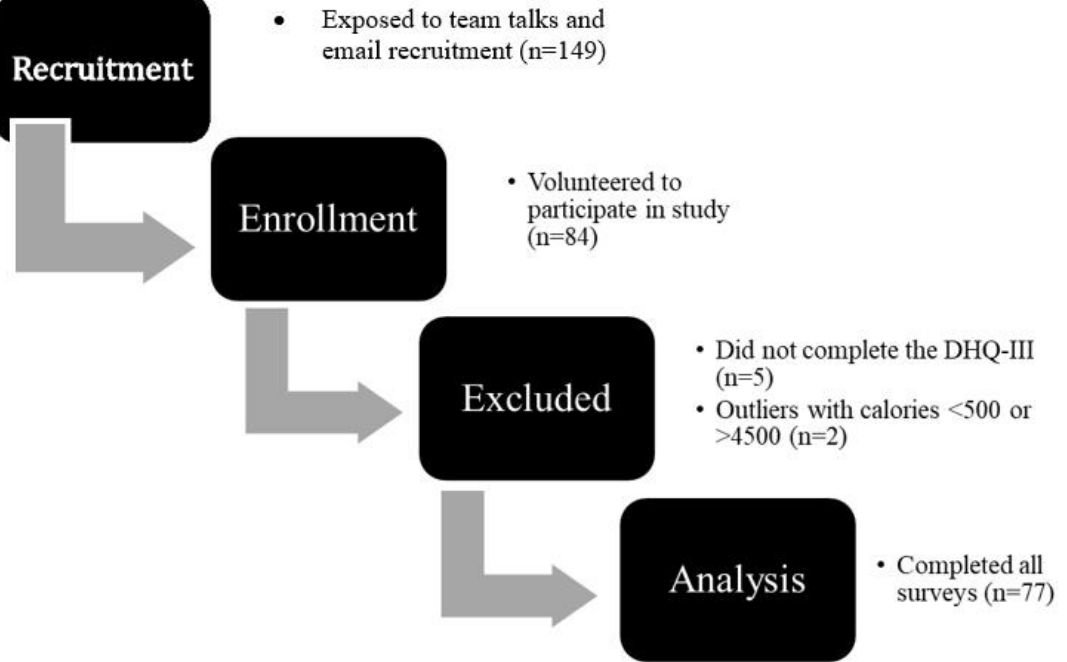
Figure 1. Flow Diagram of Participant Progress through Study Procedures.